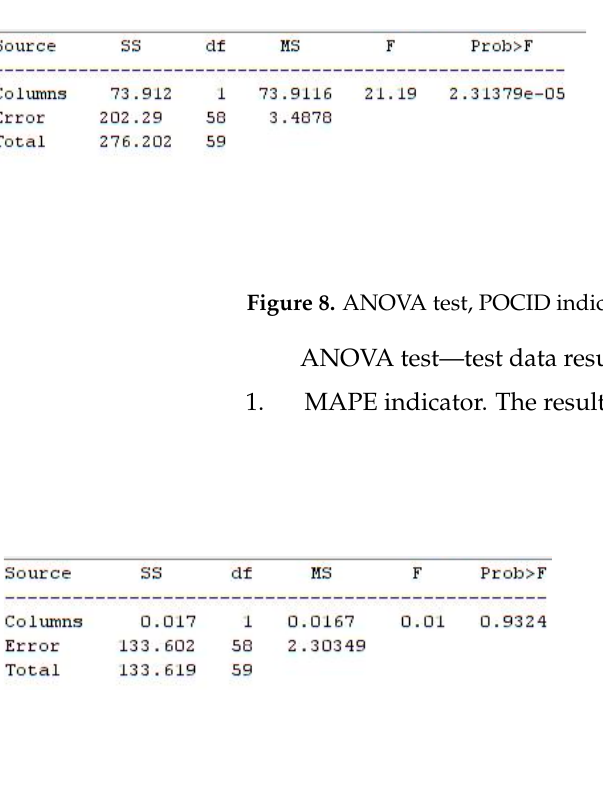
Figure 9. ANOVA test, MAPE indicator.